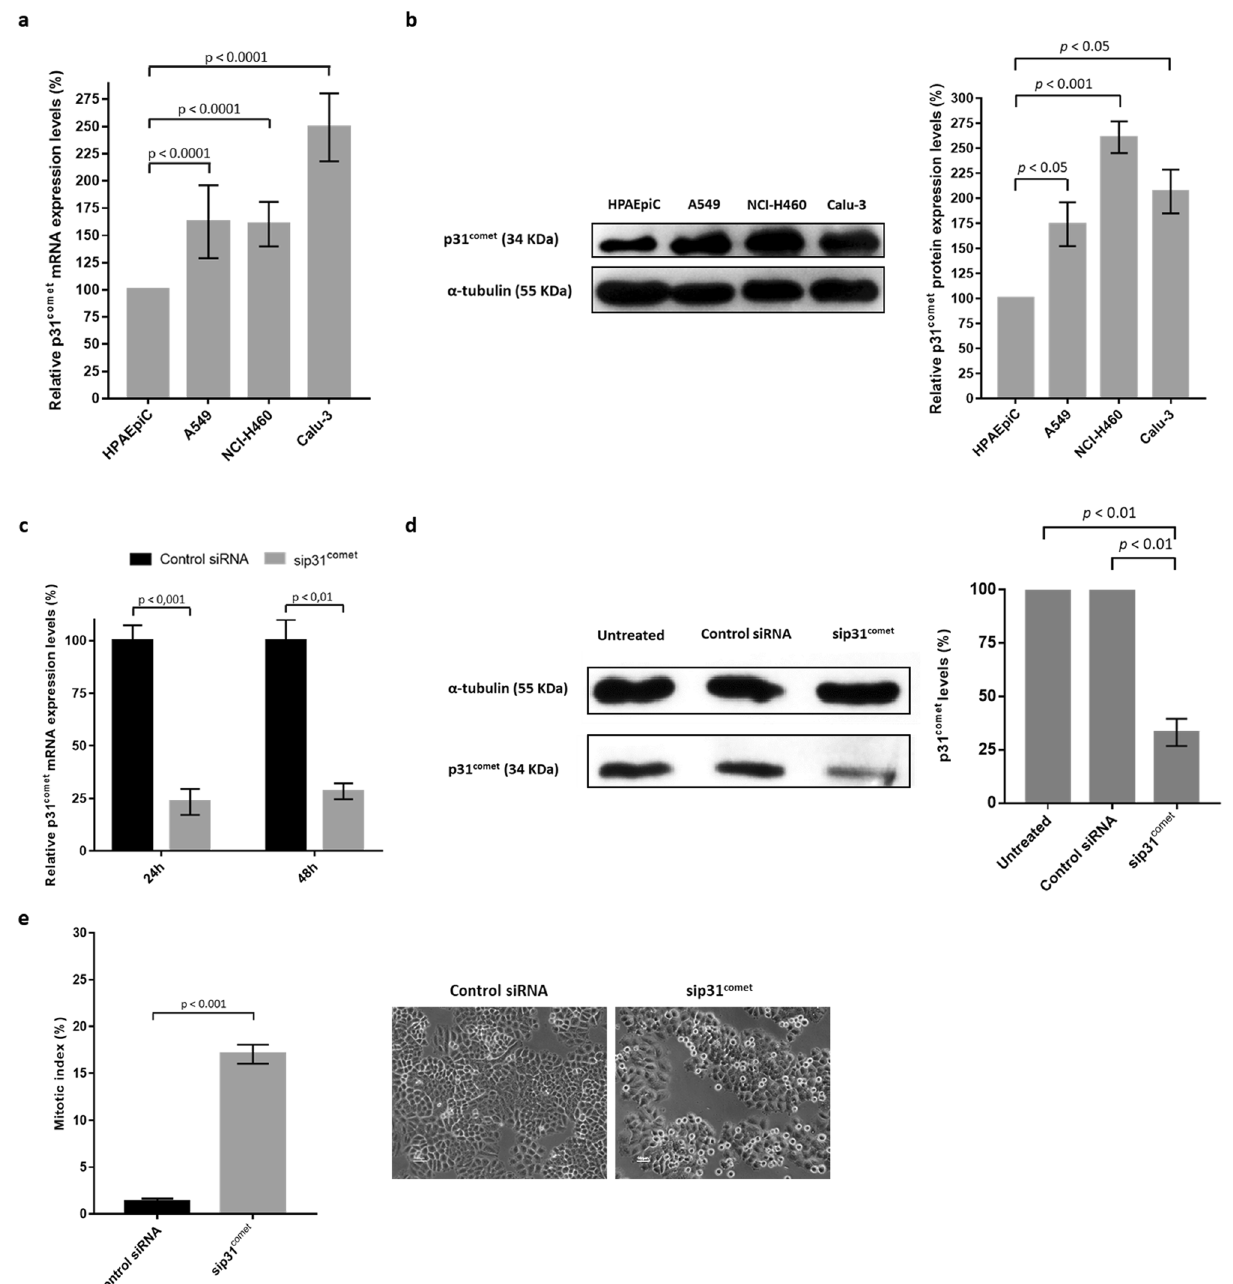
Figure 1. p31 comet expression and knockdown in lung cancer cells. p31 comet is overexpressed in lung cancer cells, as shown in ( a , b ). ( a ) Relative expression of p31 comet mRNA as determined by qRT-PCR in the indicated tumor cell lines, comparatively to non-tumor HPAEpiC. ( b ) Representative western blot showing differential expression at protein levels in cell lines analyzed in ( a ) and the respective quantification on the right (full-length blot image in Supplementary Fig. S1). Tubulin served as a loading control. ( c ) Relative expression of p31 comet mRNA in control siRNA and in cells treated with p31 comet siRNAs (sip31 comet ), as determined by qRT-PCR. RNA was extracted 24 h and 48 h after transfection. ( d ) Representative western blot for NCI-H460 extract showing effective protein depletion (left) and respective quantification (right) (full-length blot image in Supplementary Fig. S2). Tubulin served as a loading control. Protein extraction was performed 48 h after transfection. ( e ) p31 comet knockdown increases the mitotic index. Mitotic cells were quantified 48 h after transfection. Statistical analysis was performed through Student t-test. The error bars represent mean ±